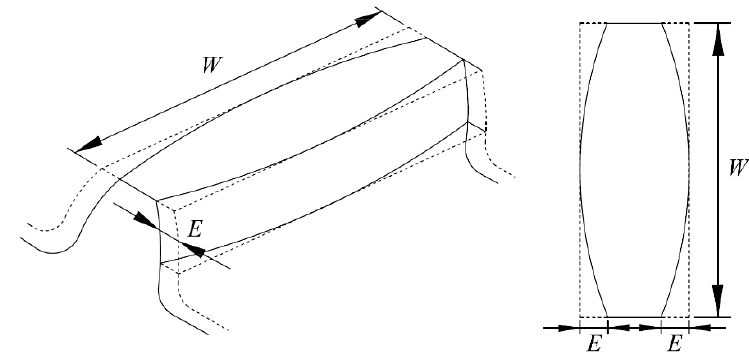
Figure 1. Illustration of longitudinal